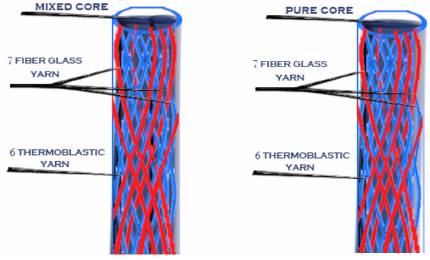
Figure 6. Sample 4 with different cores.